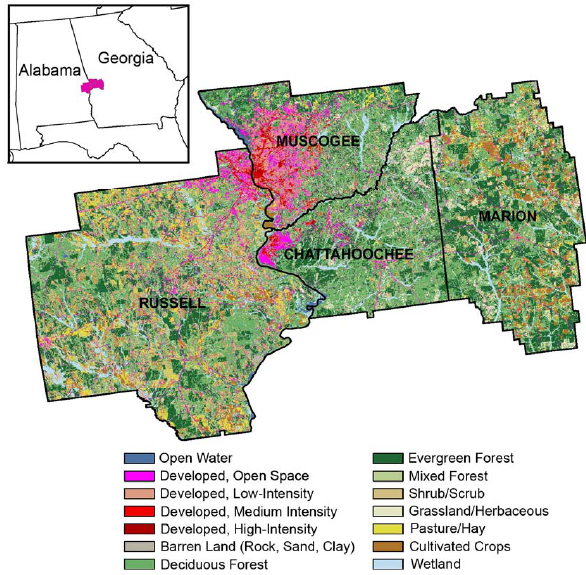
Fig. 1. The study area in Georgia and Alabama. Nearly 75% of the study area is forested, with cropland, wetland, and developed land covering most of the rest of the